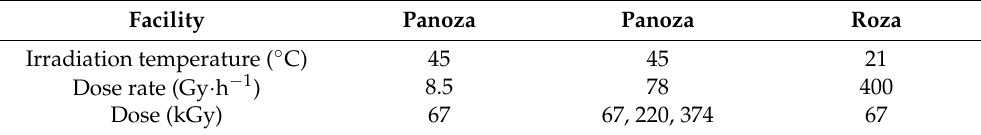
Table 1. Irradiation conditions employed in this work. Use of γ -rays under oxidative atmosphere. Facility Panoza